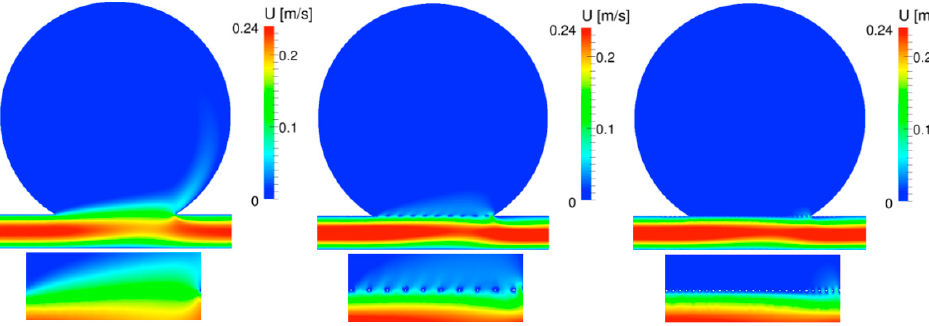
Figure 7. Velocity streamlines of the ( left ) UA, ( center ) RS, and ( right ) FD at late diastole. The flow diverter’s pore size, albeit sufficiently small to achieve flow re-channeling, is large enough to provide a scaffolding for the growing of endothelial and neointimal tissue across the aneurysmal neck [39]. Regarding the flow direction, the intensity of this effect is proportional to the stent porosity. For the diastole shown in Figures 6 and 7, the flow field in the UA is characterized by a regular vortex, which is slightly displaced towards the outflow of the aneurysm, with inflow at the distal and outflow at the proximal side of the neck. The velocity streamlines after the implant of the RS reveal some flow division close to the aneurysm’s neck, where the fluid circulates counterclockwise towards the distal inflow and clockwise towards the proximal outflow. This flow alteration is accompanied by a strong reduction in the abso- lute blood flow velocity in the aneurysmal neck and a shift of the peak values towards the parent artery. Both effects are strengthened by the implant of the FD, which shows its superior performance over the RS in this region. Thus, the numerical results clearly show that the flow impingement on the aneurysmal wall in the distal neck region reduces with decreasing stent porosity. With the decrease in stent porosity, the magnitude of the vortical flow is decreased. Figures 8 and 9 show the vorticity contours at the different cross sections marked in Figure 3. The magnitude of the vorticity perpendicular to the plane is displayed, where blue and red colors indicate clockwise and counterclockwise rotation, respectively. For all cross- sections, the magnitude of the vorticity is significantly reduced through the deployment of the RS and the FD; note the different scales used at the different cross-sections.